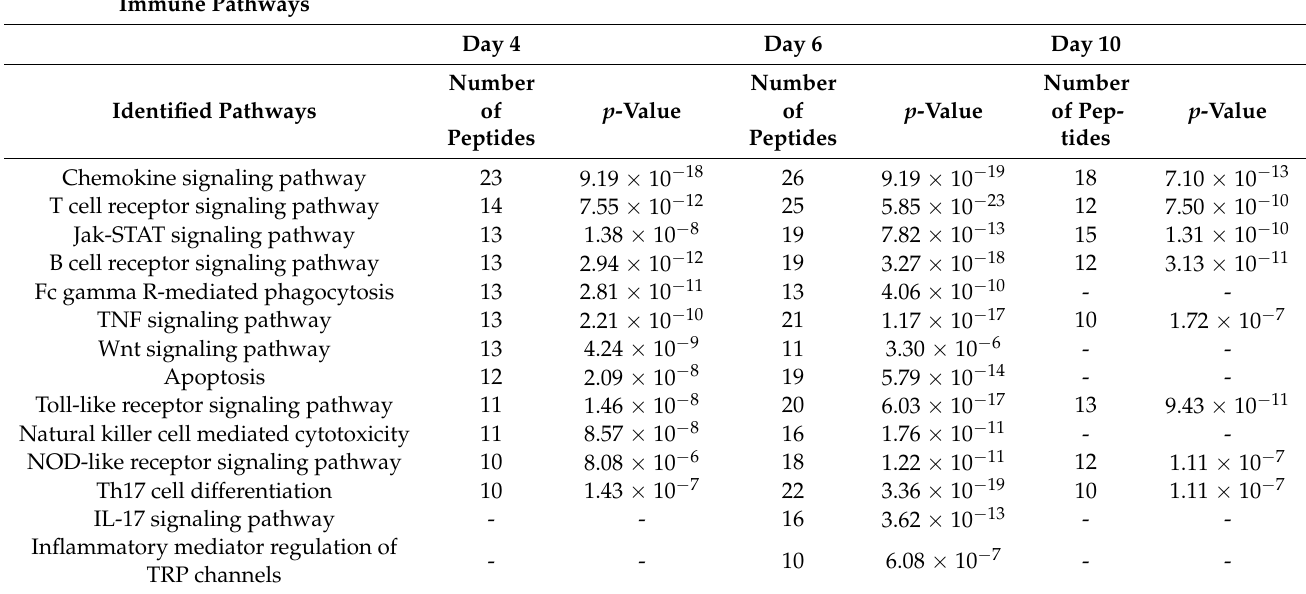
Table 1. Summarized table of Kyoto Encyclopedia of Genes and Genomes (KEGG) immune pathways at days 4, 6, and 10 comparing 1% ChT-fed birds and control birds. The hyphens indicate fewer than ten peptides and a lack of significance for our analysis. The JAK-STAT signaling pathway has been highlighted.